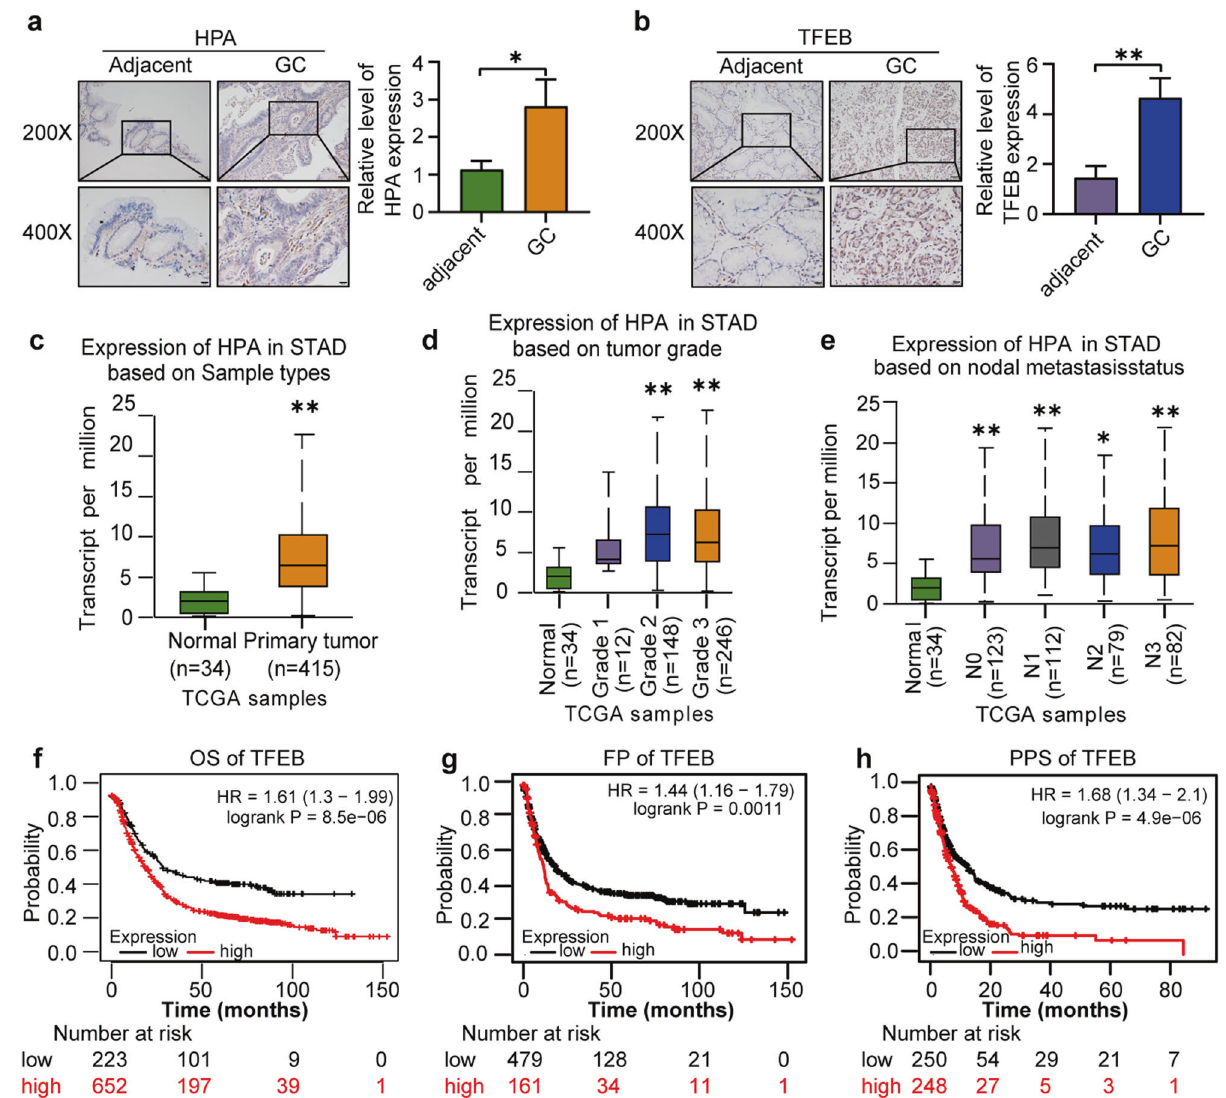
Fig. 8 Aberrant expression of HPA and TFEB in gastric cancer. Immunohistochemical analysis of HPA ( a ) and TFEB ( b ) expression in gastric tissues. c Relative expression level of HPA in normal gastric tissue and gastric primary tumors from UALCAN database. d Relative expression of HPA in gastric cancer based on tumor grade from UALCAN database. e expression of HPA in gastric cancer based on lymph nodal metastasis status from UALCAN database. Kaplan – Meier analysis from TCGA database of the correlation between relative expression of TFEB and overall survival (OS) ( f ), fi rst progression (FP) ( g ), or post-progression survival ( h ). * P < 0.05, ** P < 0.01 versus the adjacent or normal group. STAD stomach